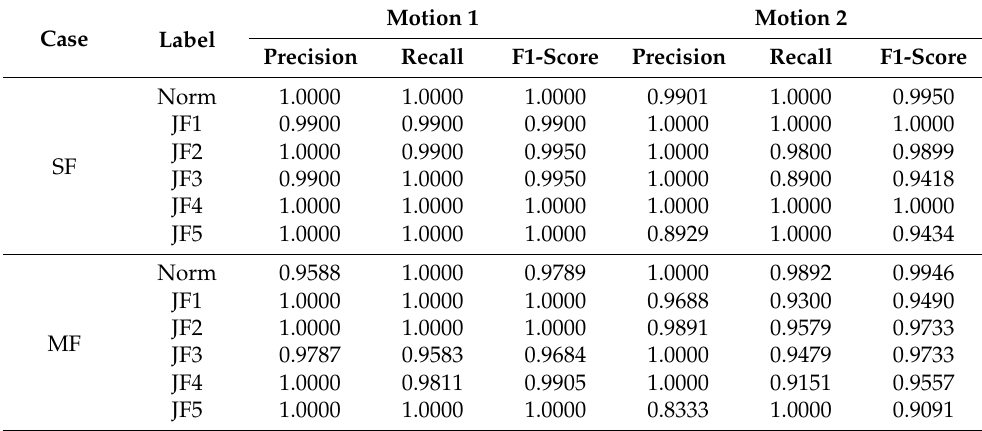
Table 9. The recognition results of DCNN on SF and MF